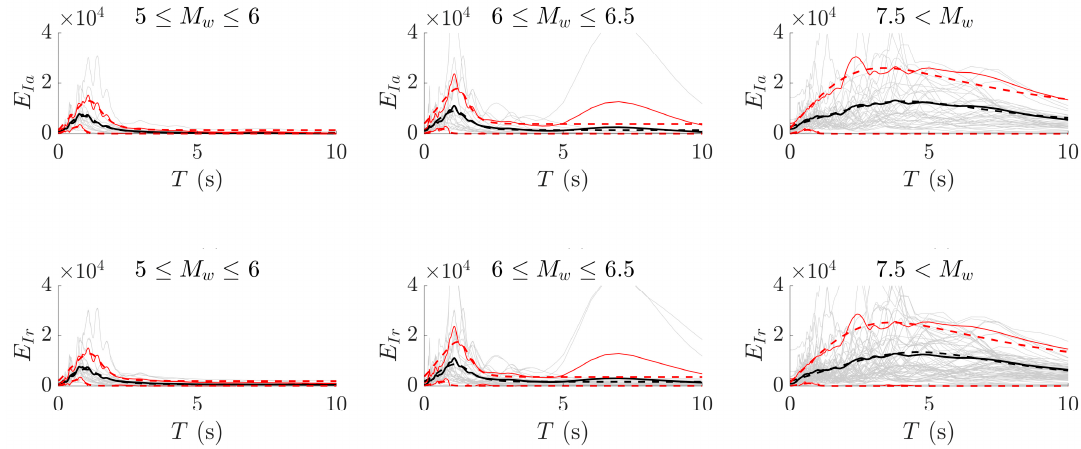
Figure 10. Comparison between calculated absolute input elastic energy E Ia spectra (mean and mean plus / minus one standard deviation) and proposed approximation (thin solid line: single spectrum; thick solid line: calculated spectrum; thick dashed line: proposed approximation).